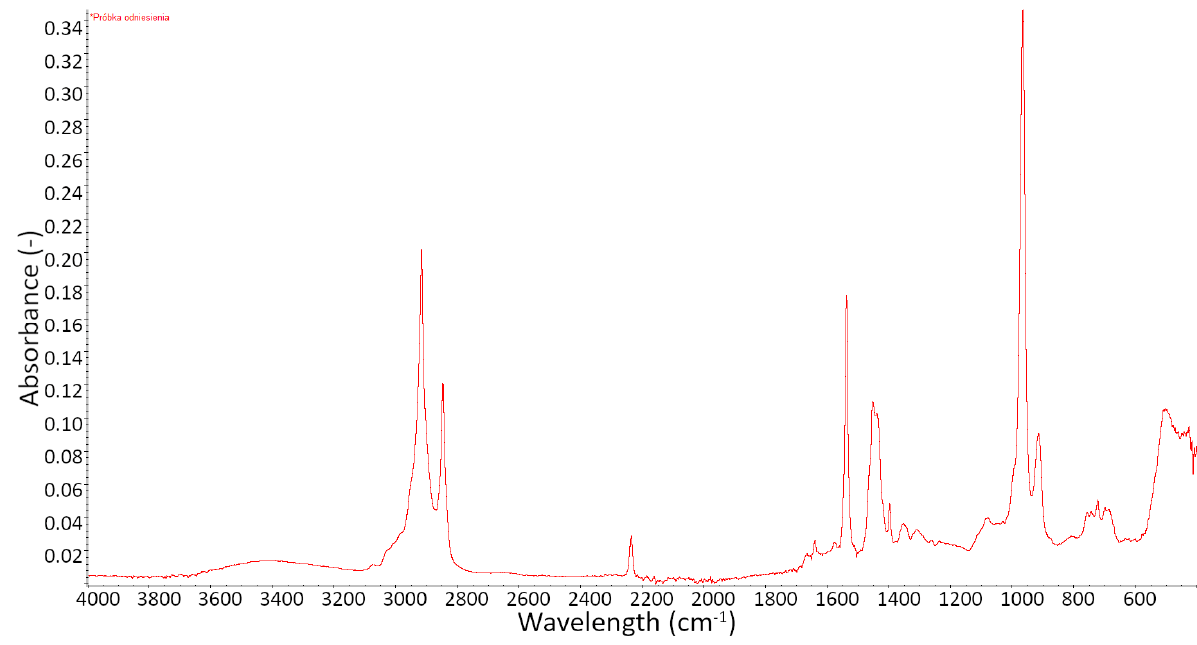
Figure 5. FT-IR spectrum of the reference.